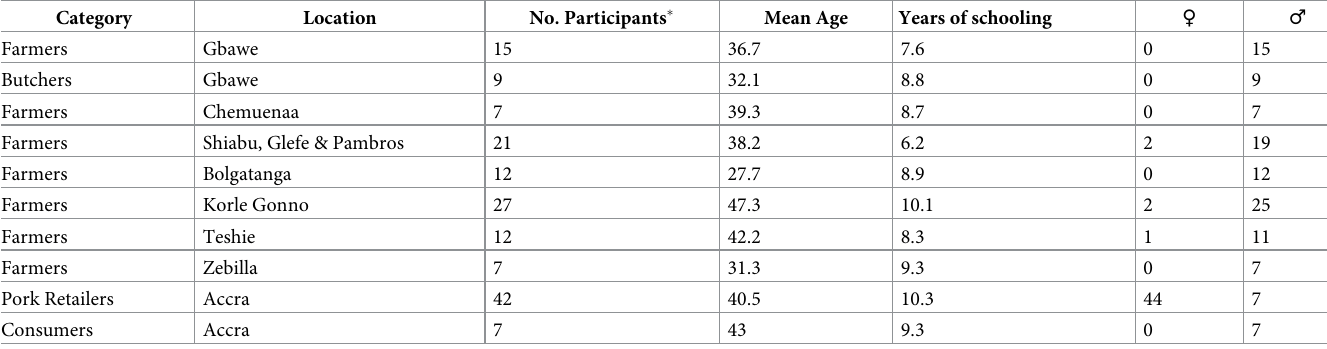
Table 3. Value chain focus group discussions.